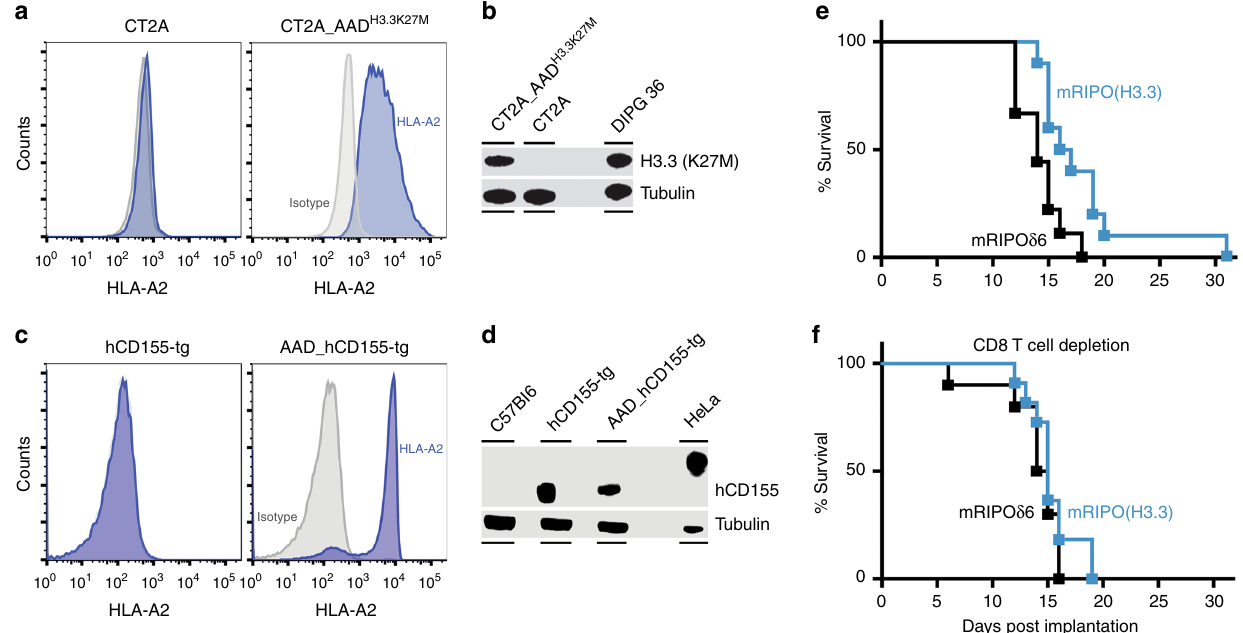
Fig. 7 mRIPO(H3.3) immunization extends survival in an intracerebral glioma model. a , b CT2A cells were transduced with HLA-A2 (AAD) ( a ) and full- length mouse histone 3.3(K27M) (b). DIPG 36 is a human H3.3 K27M + DIPG cell line used as a positive control. c , d AAD_hCD155 transgenic mice express HLA-A2 (AAD) in splenocytes ( c ) and hCD155 (in brain; d ). HeLa cells were used as a positive control (the differences in hCD155 electrophoretic mobility are due to differential glycosylation). e AAD_hCD155 transgenic mice were immunized by i.m. inoculation (day 1), implanted with CT2A_AAD H3.3K27M cells for orthotopic tumor initiation (day 7), boosted with the same regimen (day 14), and followed for assessment of weight and neurological status. Mice were euthanized after losing 15% of their max. weight. mRIPO(H3.3)-immunized mice survived signi fi cantly longer than their mRIPO δ 6-immunized littermates [ P = 0.0121, Log-rank (Mantel-Cox) test; mRIPO δ 6 n = 9 animals, mRIPO(H3.3) n = 10]. A replicate is shown in Supplementary Fig. 19. ( f ) CD8 depletion abrogates the anti-tumor effect of mRIPO(H3.3) immunization. The assay was performed as in ( e ), with CD8 depletion antibody administered every 4 days starting at 7 days prior to tumor implantation [ P = 0.3493, Log-rank (Mantel-Cox) test; mRIPO δ 6 + α CD8 n = 10 animals; mRIPO(H3.3) + α CD8 n =